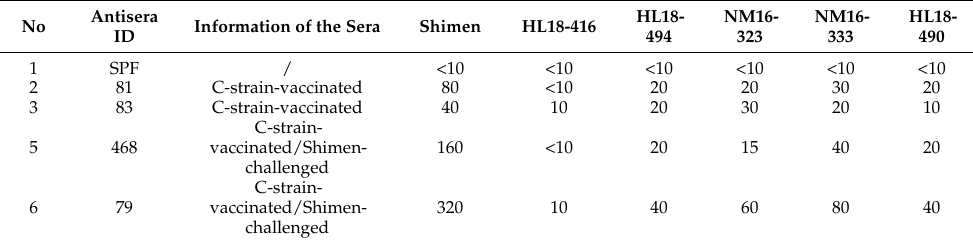
Figure 7. One-step growth curve analysis. Growth kinetics of the CSFV HL18-494, NM16-323 and Shimen strains was depicted by one-step growth curve. An MOI of 5 was used to infect PK-15 cells. The cell cultures were harvested at various time points and TCID 50 was calculated. The mean values with standard deviations of three independent experiments were calculated. *, p < 0.05; **, p < 0.01, compared with the Shimen strain. Table 6. Neutralization titers of anti-C-strain sera against various CSFV